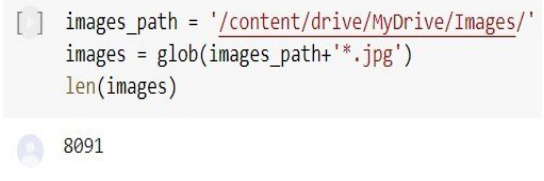
Fig. 3. Total number of images in the dataset